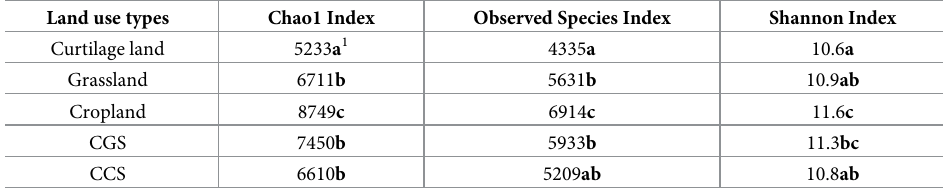
Table 1. Mean values of bacterial richness and diversity